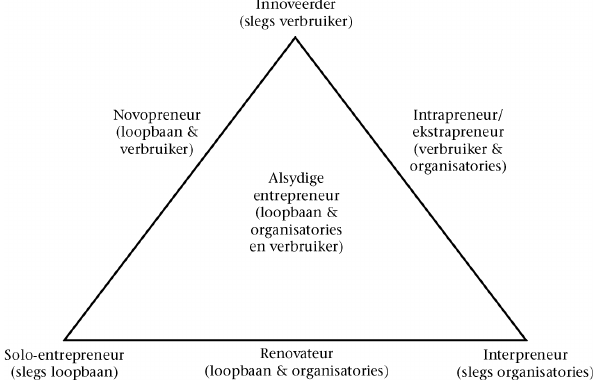
Figuur 7: Soorte entrepreneurskap as verskillende kombinasies van die drie kontekstuele eenhede van